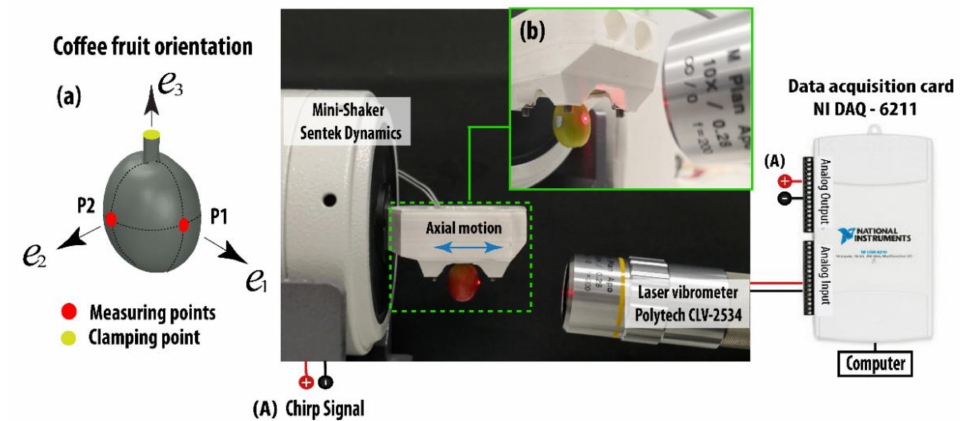
Figure 3. Experimental setup for velocity measurements applying linear chirp excitation. ( a ) Coffee fruit orientation system ( e 1 - e 2 - e 3 ), and measuring points. ( b ) View of the measurment proccess with the